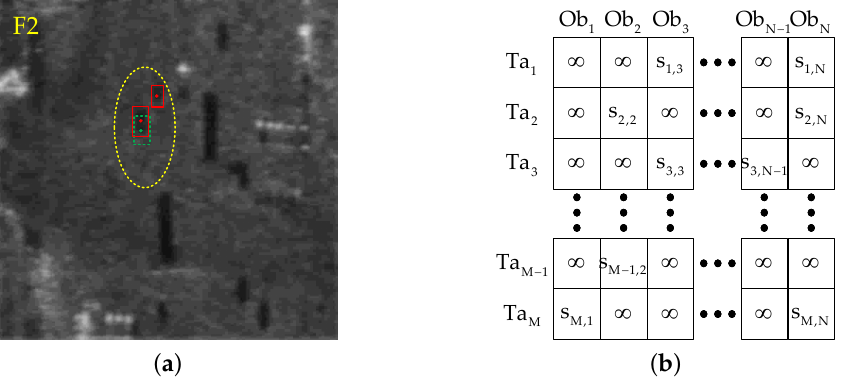
Figure 12. Diagrams of major steps in data association. ( a ) The grouping result based on Mahalanobis distance. The green box denotes the predicted location of a target in search frame F2. The yellow line means the threshold of the Mahalanobis distance. The red boxes are the possible observations of the target. ( b ) The similarity matrix between all targets and all observations. ‘Ta’ denotes a target and ‘Ob’ denotes an observation. ‘ s M , N ’ denotes the similarity between the target M and the observation N . ‘ ∞ ’ means the similarity is infinite.